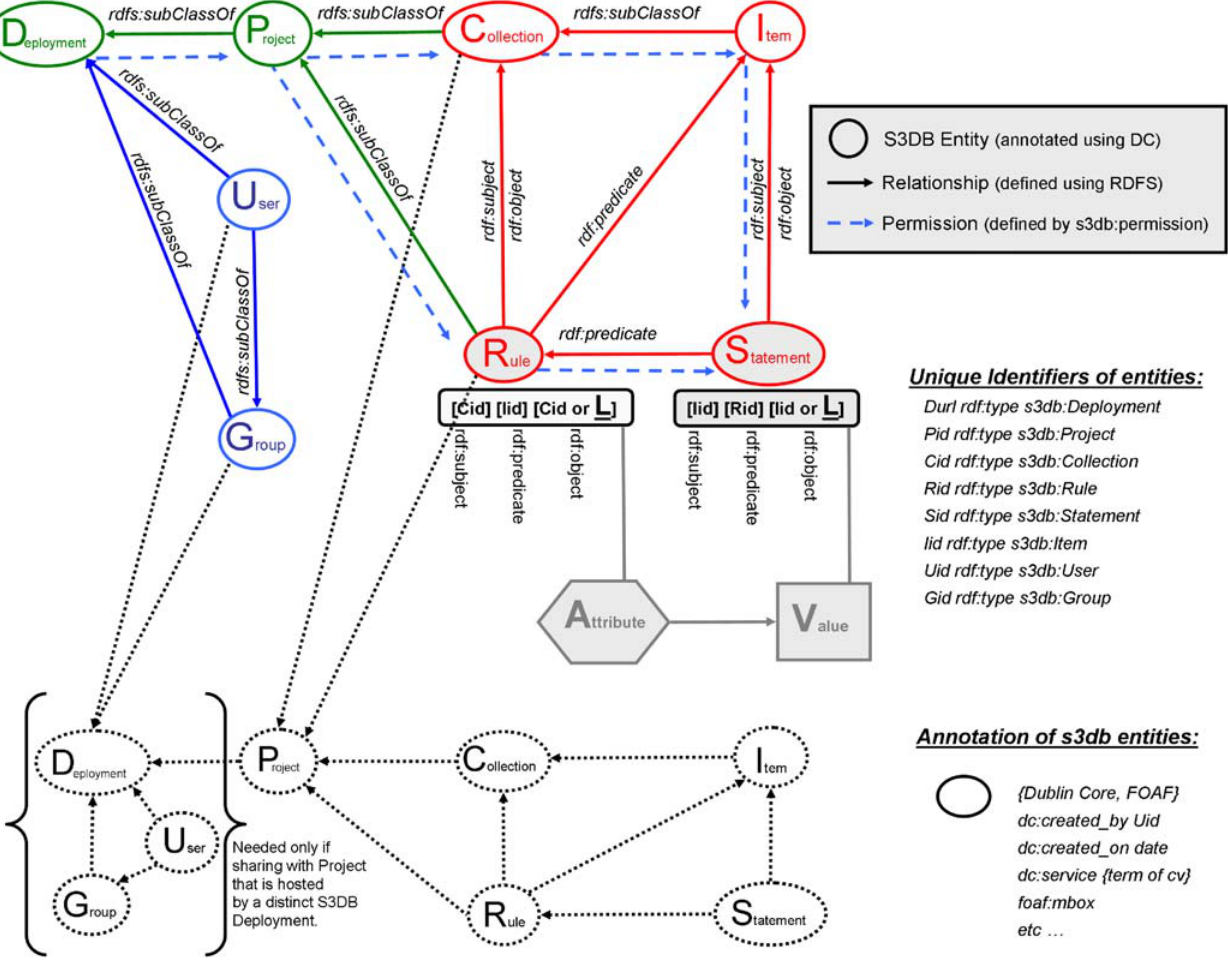
Figure 4. Core model developed for S3DB (supported by version 3.0 onwards). This diagram can be read starting from the most fundamental data unit, the Attribute-Value pair (filled hexagonal and square symbols). Each element of the pair is object of two distinct triples, one describing the domain of discourse, the Rules , and the other made of Statements where that domain is populated to instantiate relationships between entities. The latter includes the actual Values. Surrounding these two nuclear collection of triples, is the resolution of Collection and its instantiation as Item that define the relationship between the individual elements of Rules and Statements . The resulting structure is then organized in Projects in such a way that the domain of discourse can nevertheless be shared with other Projects , in the same or in a distinct deployment of S3DB. Finally, a propagation of user permissions (dashed line) is defined such that the distribution of the data structures can be traced. See text for a more detailed description.